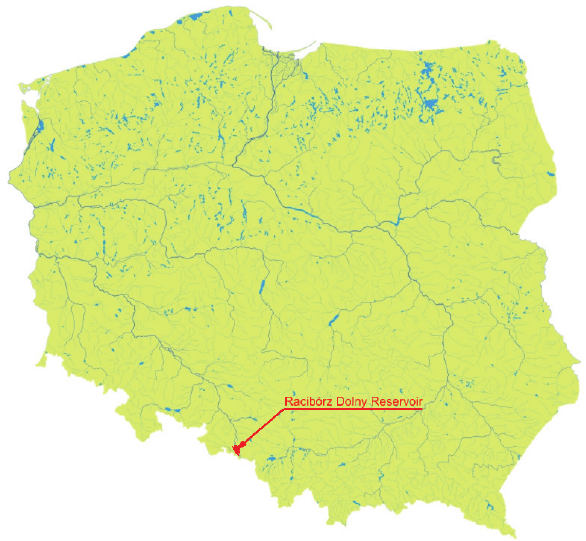
Figure 1: Localization of the reservoir on the hydrographic map of Poland (Aoteroa, 2006).